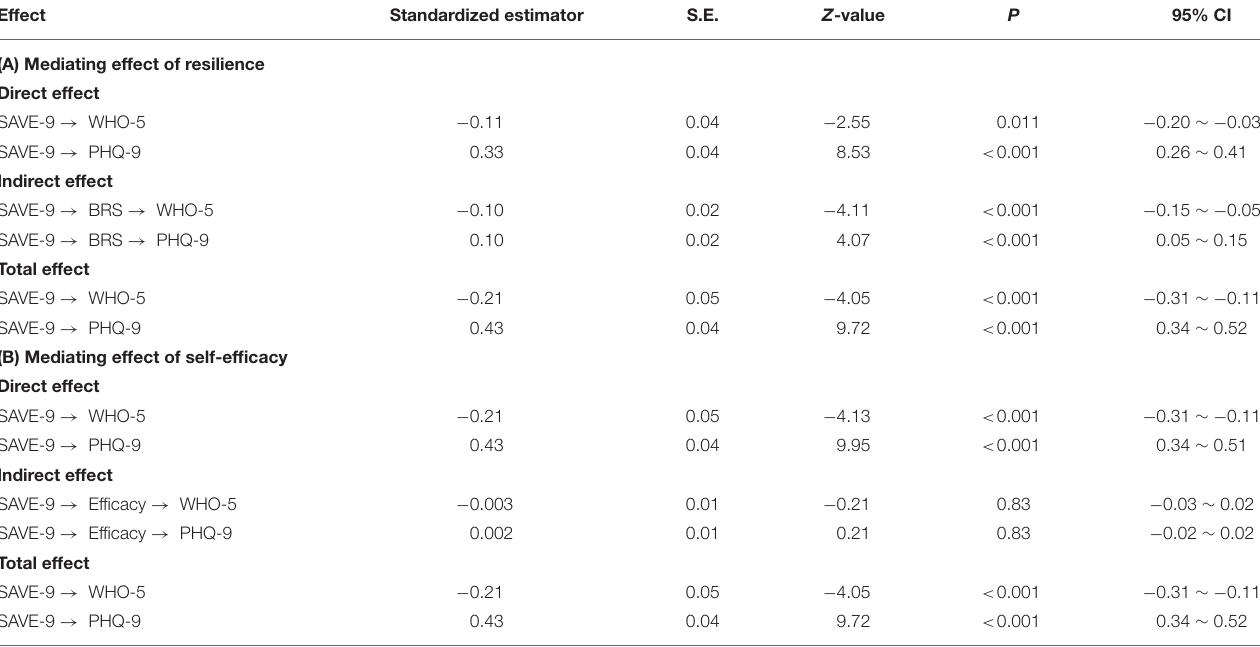
TABLE 5 | Mediating effect of resilience or self-efficacy on the association between stress and anxiety to the viral epidemic and depression or psychological well-being.